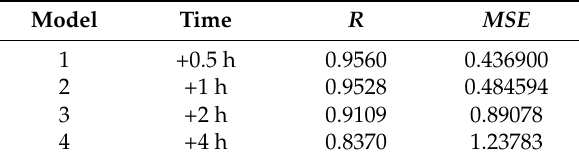
Table 5. Performances of the forecasting models (input parameter = outdoor temperature)